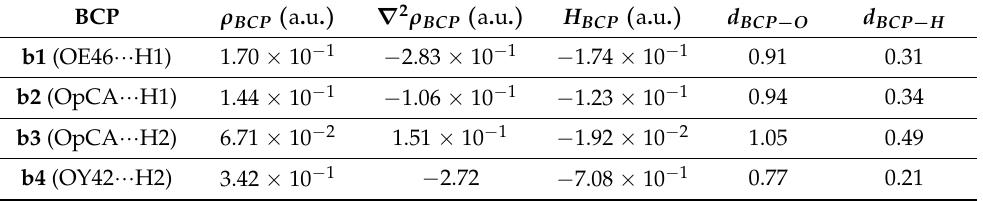
Table 2. Electron density ( ρ BCP ), laplacian ( ∇ 2 ρ BCP ), and total electronic energy density ( H BCP ) calculated at the bond critical points (BCPs) found along the short HBs between pCA and E46/Y42. The locations of the BCPs ( b1 – b4 ) are shown in Figure 5. The distances (in Å) between every BCP and the atoms (O and H) that it connects are also given. BCP ρ BCP ( a . u . ) ∇ 2 ρ BCP ( a . u .